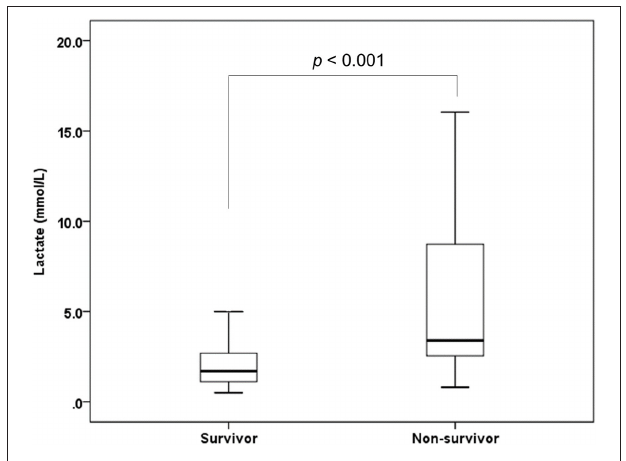
FIGURE 1 | Box and Whisker plot illustrating distribution of serum lactate level between survivor group and non-survivor group of SAH.